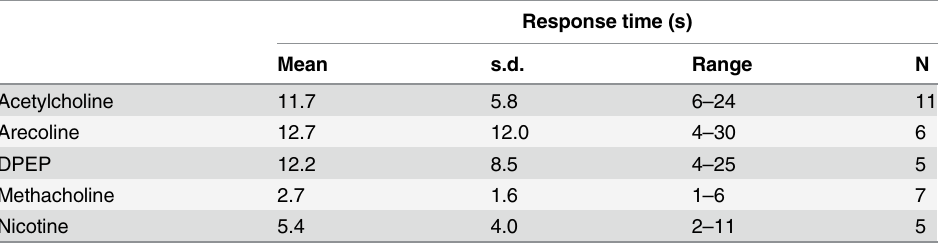
Table 3. Response times (delay between addition of agent and start of response) of P. lividus CDs treated with cholinergic agonists.